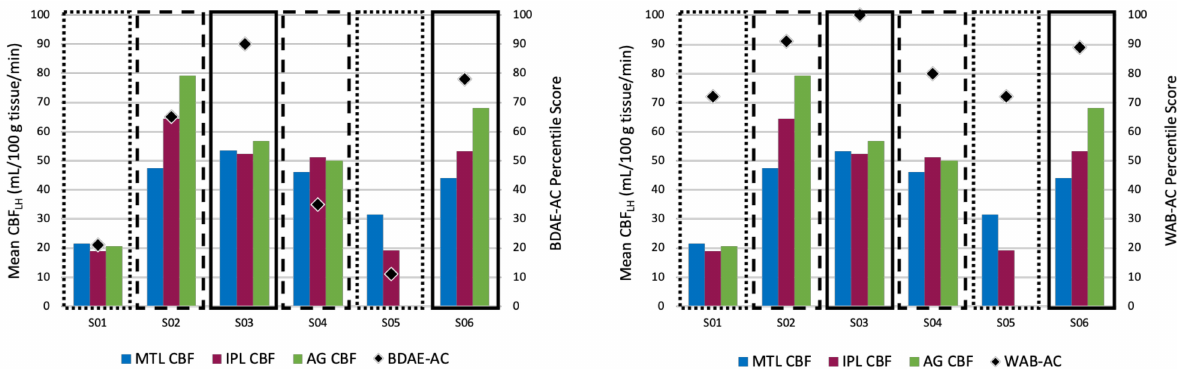
Figure 4. Individual CBF patterns in ROIs that were significantly correlated with the BDAE-AC ( left ) and the WAB-AC ( right ) and percentile scores. Dotted boxes represent individuals with Broca’s aphasia who performed the worst on the two auditory comprehension measures. Dashed boxes represent individuals with Broca’s aphasia who performed poorly on the BDAE-AC but not the WAB-AC. Solid boxes represent individuals with Anomic aphasia who performed well on the two auditory comprehension measures. MTL: medial temporal lobe; IPL: inferior parietal lobe; AG: angular gyrus. Note : S05 had a CBF value near zero in the AG, likely due to a small number of voxels not included in the lesion